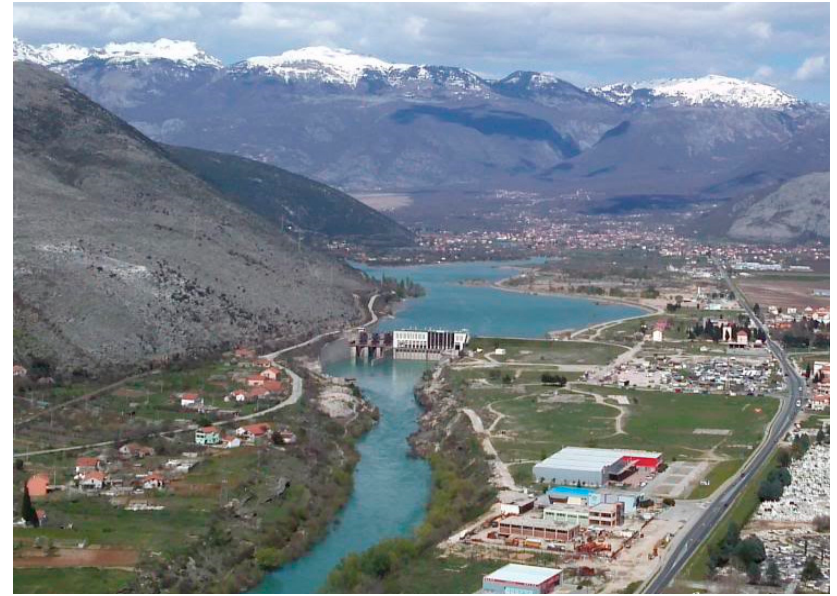
Figure 1. Disposition—HEPP Mostar [1].